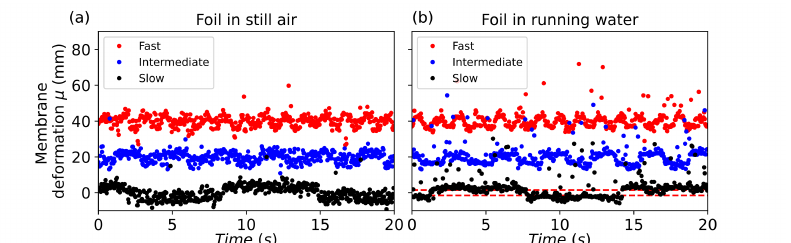
Figure 6. Membrane displacement measurements in ( a ) still air and ( b ) running water at three actuation frequencies: slow, intermediate, and fast. It is noted that the intermediate and fast actuation measurements are plotted with a vertical offset of 20 and 40 mm, respectively. The slow actuation measurement does not have an